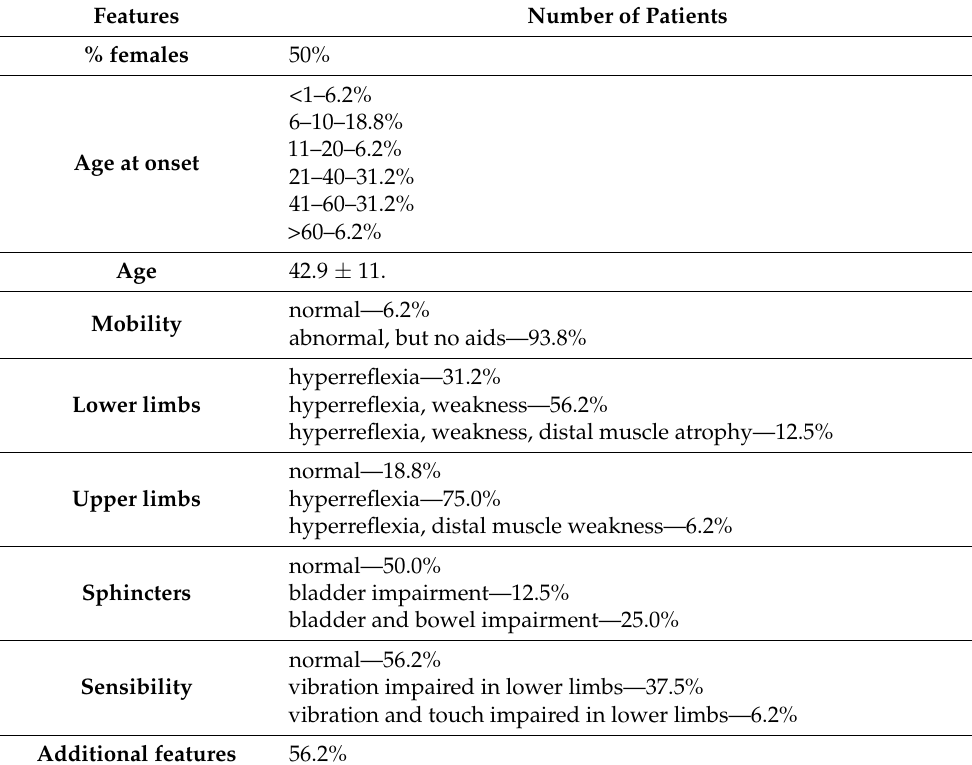
Table 2. Main clinical findings of Serbian patients with genetically confirmed